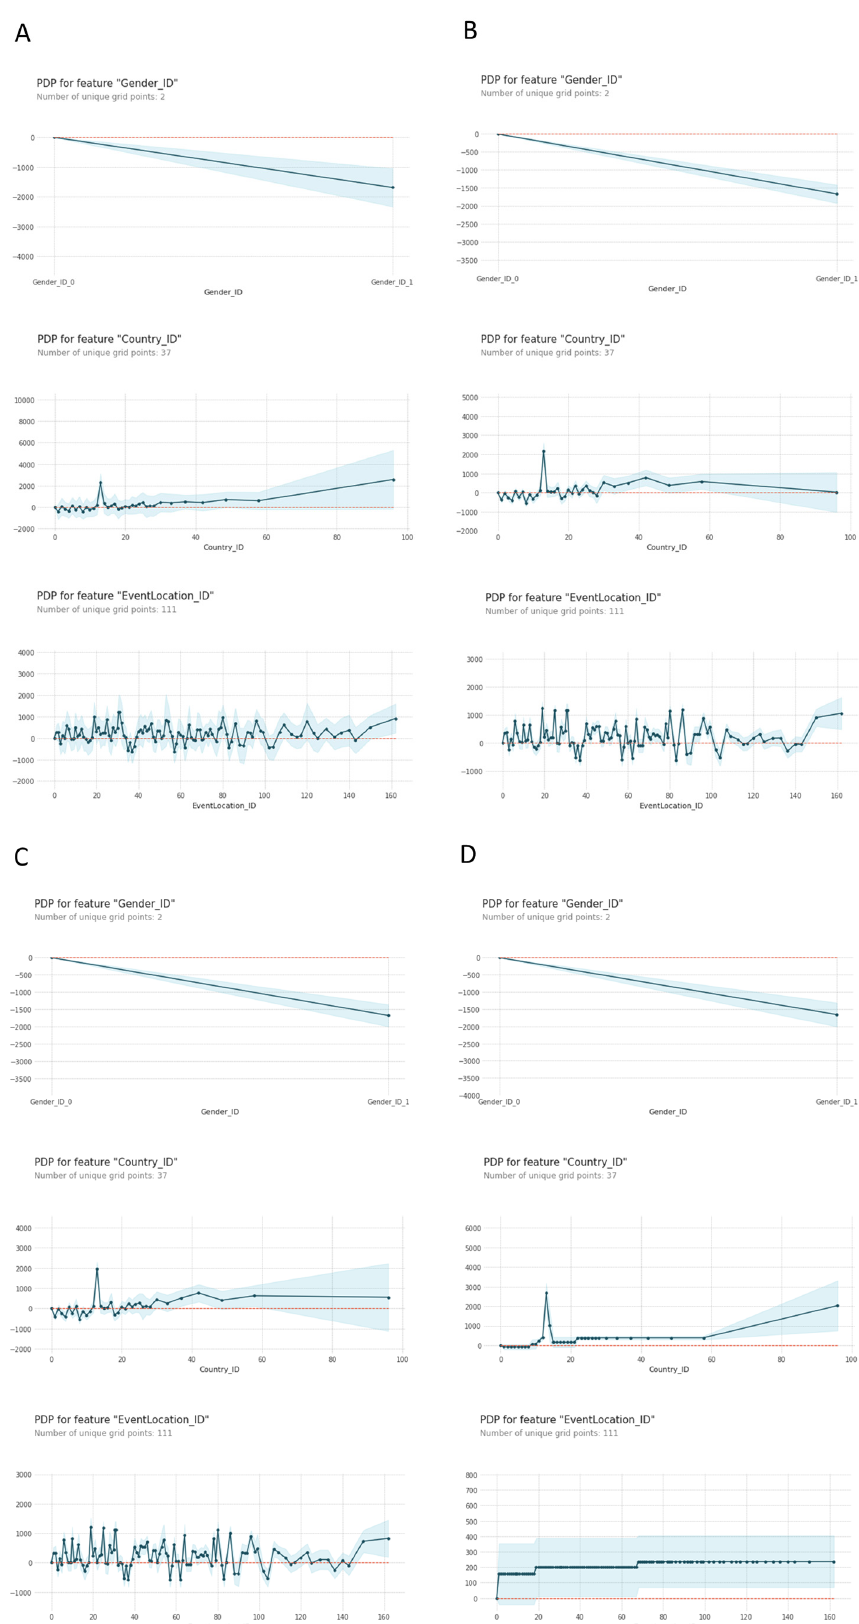
Figure 3. PDP plots of PDP plots of ( A ) Algorithm Random Forest Regressor, ( B ) Algorithm XG Boost Regressor; ( C ) Algorithm Cat Boost Regressor, and ( D ) Algorithm Decision Tree.